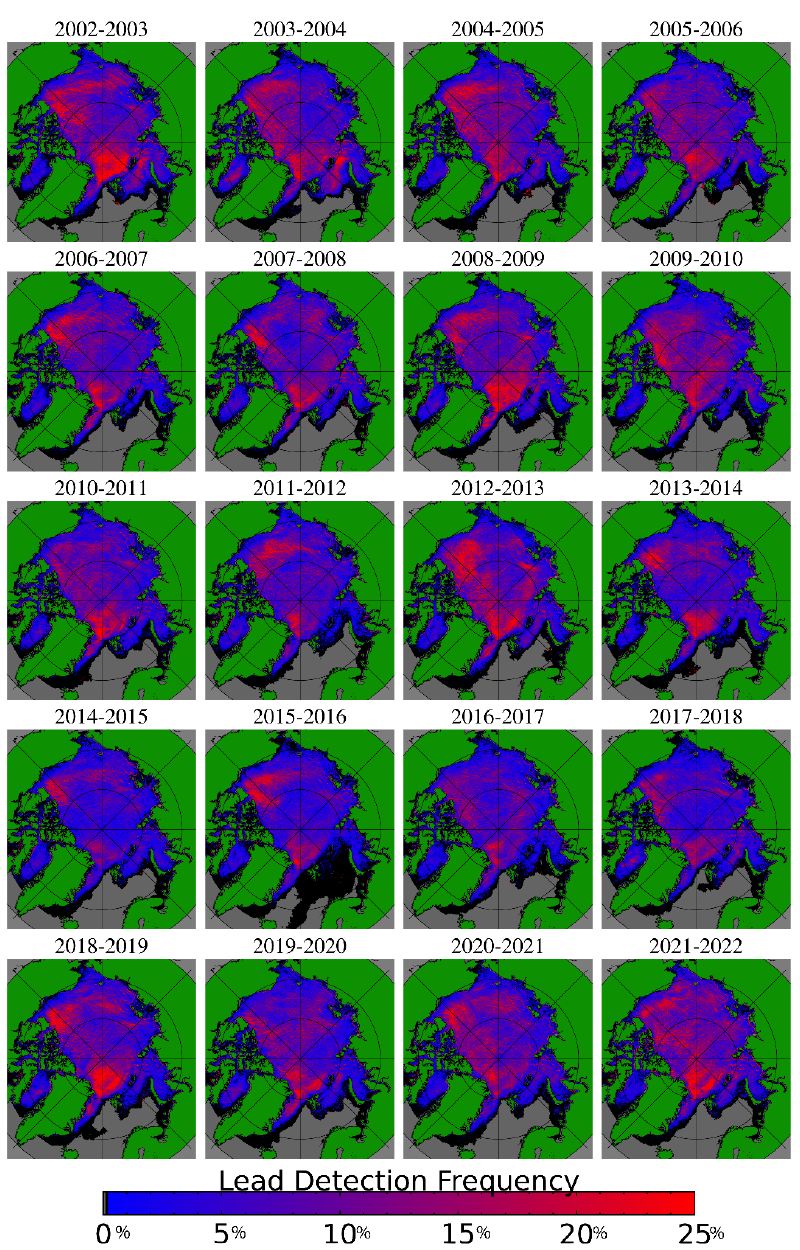
Figure 1. Winter lead frequency by year, reported as the percentage of days between November and April with a lead detection at each location. Gray indicates locations where the sea ice mask [27] shows no continuous sea ice, and black indicates area where no leads are detected.